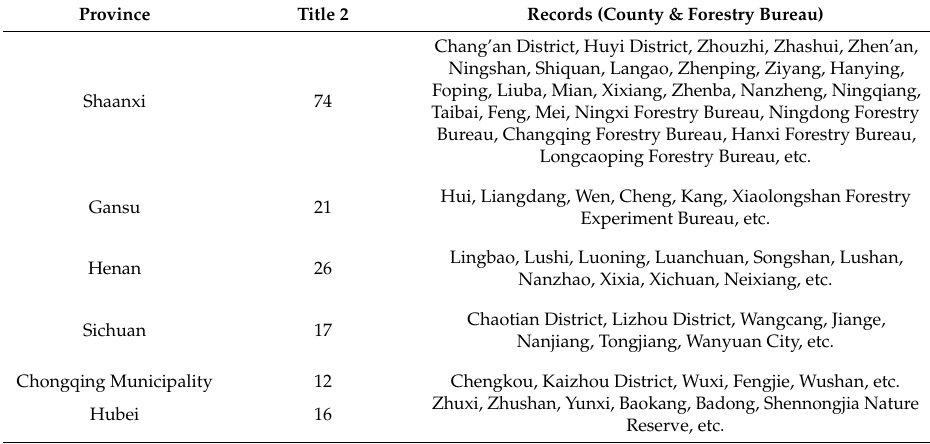
Table 4. Occurrence records of D.